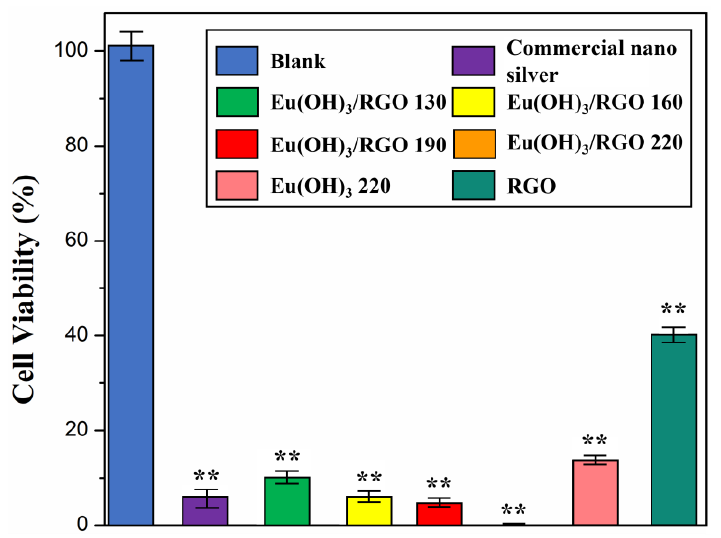
Figure 9. Viability rate (%) of different samples against E. coli (10 4 CFU/mL) after 30 min. A concentration of 8 µg/mL was used for all the samples. Error bars represent the standard deviations (n = 3; n = numbers of experimental results); ** p < 0.01 indicates statistically significant compared with the control group.